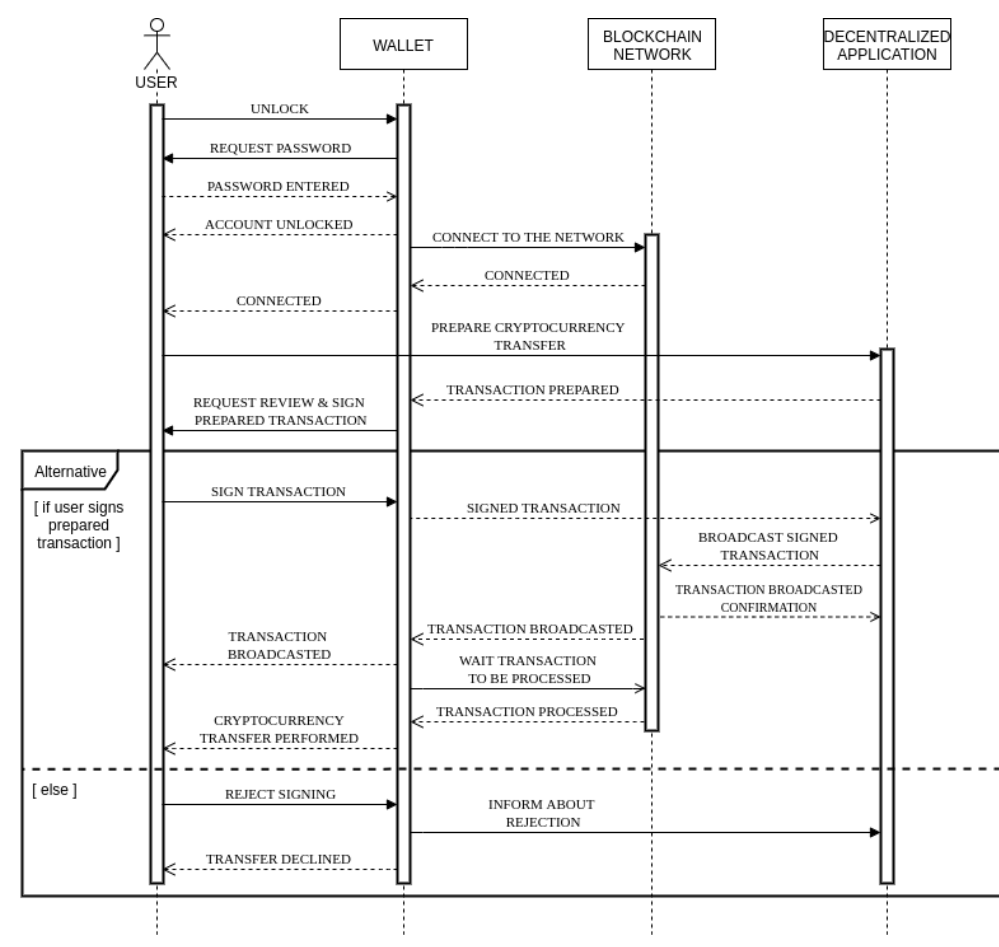
Figure 1. Current digital signing process using a decentralized